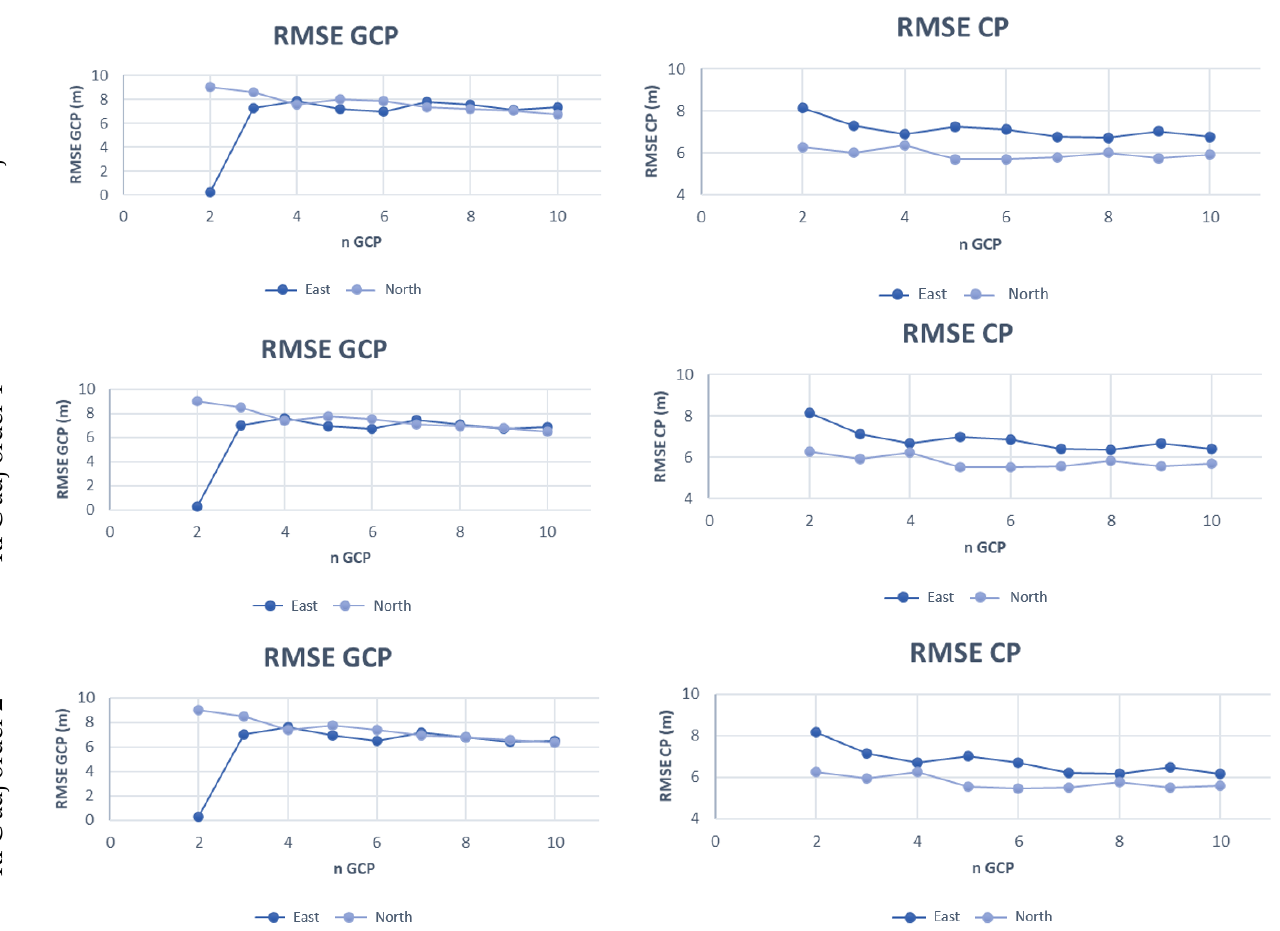
Figure 8. Precision and accuracy trends for Ischia image.